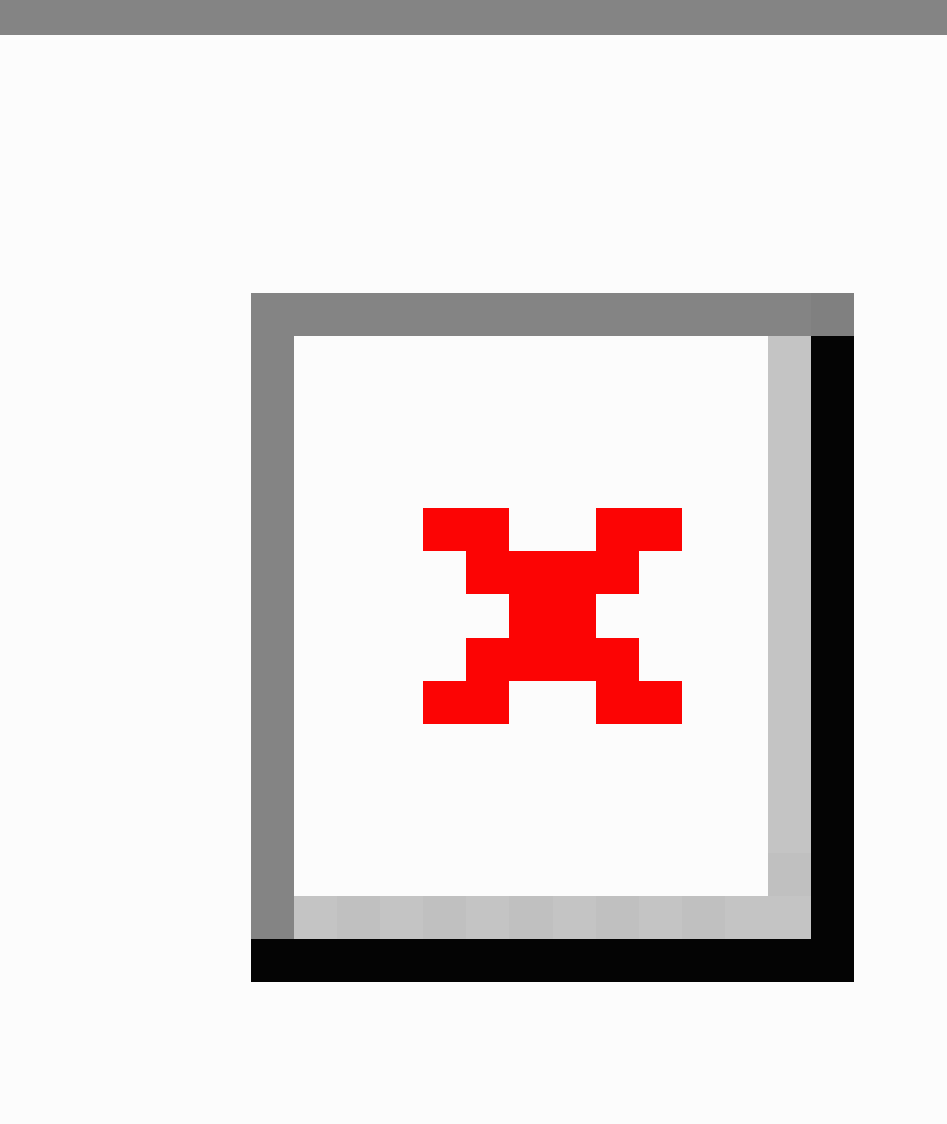
Figure 1. The ‘‘5S’’levels of organization of evidence from health care research (adapted from Haynes